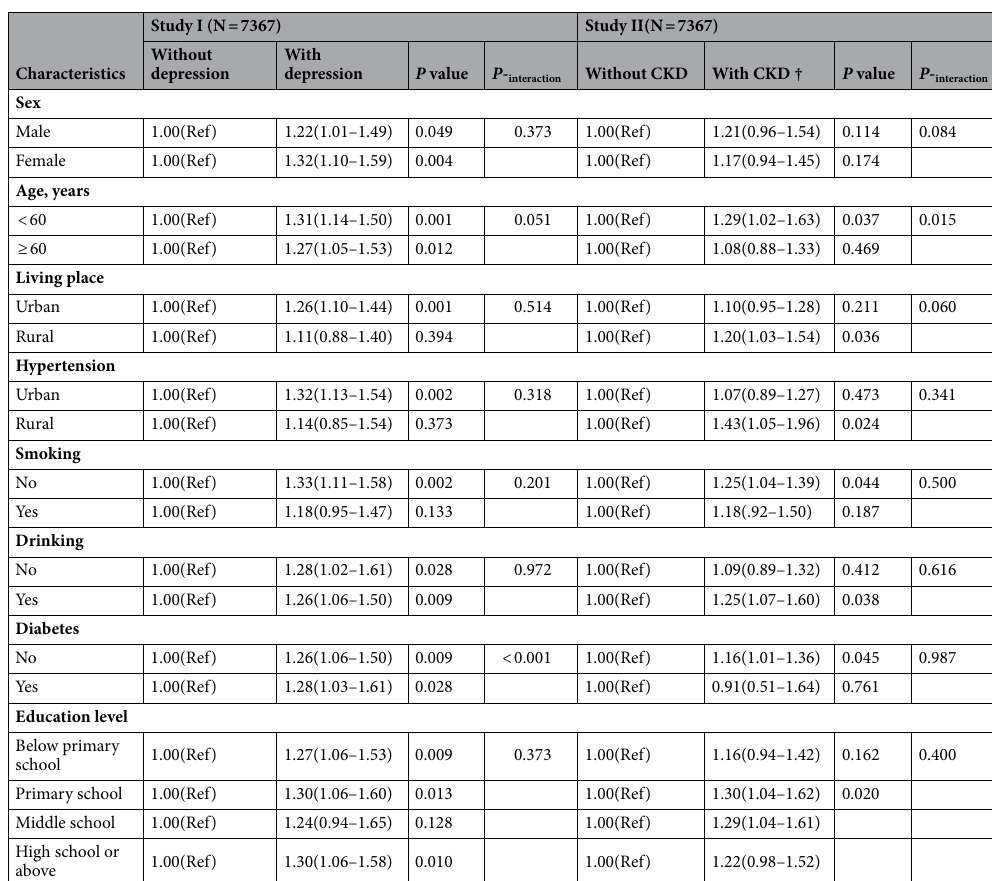
Table 4. Subgroup analysis of the bidirectional association between depression and kidney disease. In the multivariate models, confounding factors such as Multivariable-adjusted for age, sex, living place, education level, smoking, drinking, body mass index, systolic blood pressure, and medical history (dyslipidemia, diabetes, cancer, heart disease, stroke, asthma, lung disease, liver disease, digestive disease, and memory problem) were included unless the variable was used as a subgroup variable. † CKD eGFR < 90 mL/min per 1.73 m 2 or with reported kidney